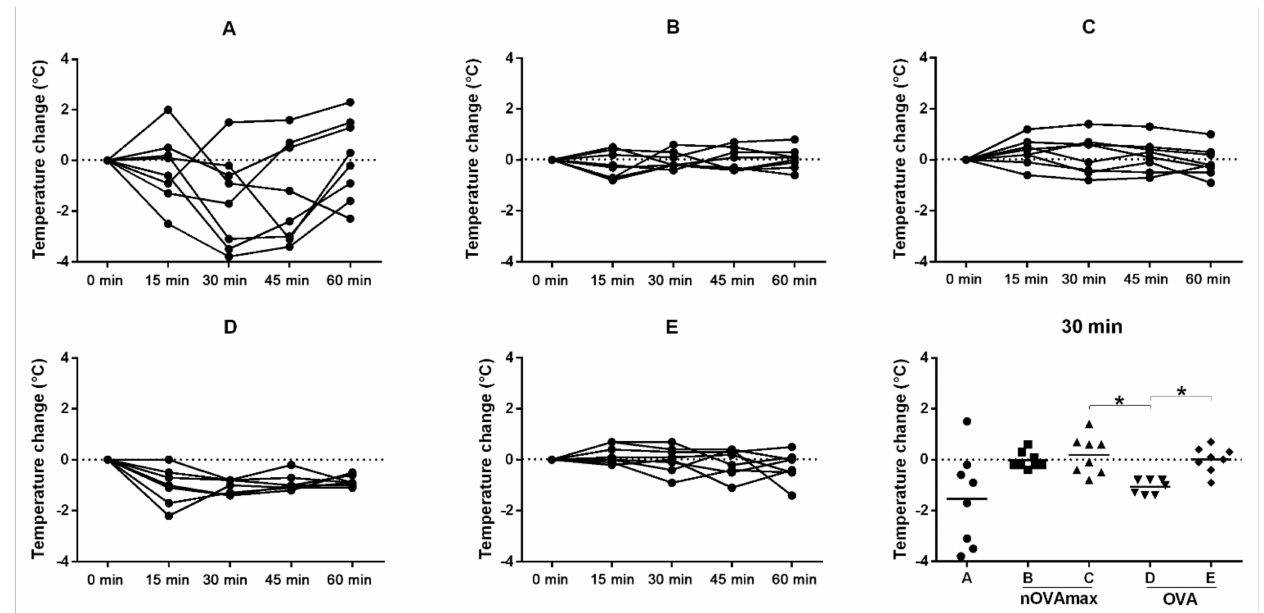
Figure 5. Measurement of the core body temperature for each mouse after oral challenge with 2 mg OVA. The baseline body temperature (0 min) of each mouse was measured prior to challenge, and body temperature was observed until 1 h after challenge (measurement timepoints: 15, 30, 45, 60 min after challenge). For each mouse, the temperature difference between the timepoints was calculated, and the changes in body temperature are shown in the graphs ( A – E ). The last graph illustrates all the measurements at the 30 min timepoint after oral challenge, and the values were compared using the Kruskal–Wallis non-parametric test with Dunn’s multiple correction (* p <